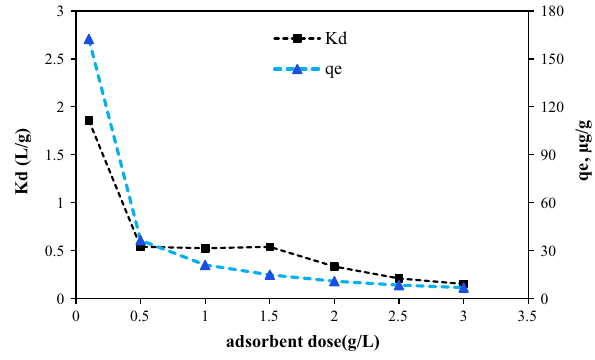
Fig. 2 Effect of adsorbent dosage on arsenic removal using modified saxaul ash (initial arsenic concentration of 100 µg/L, optimum pH of 7, contact time of 60 min and temperature of 298